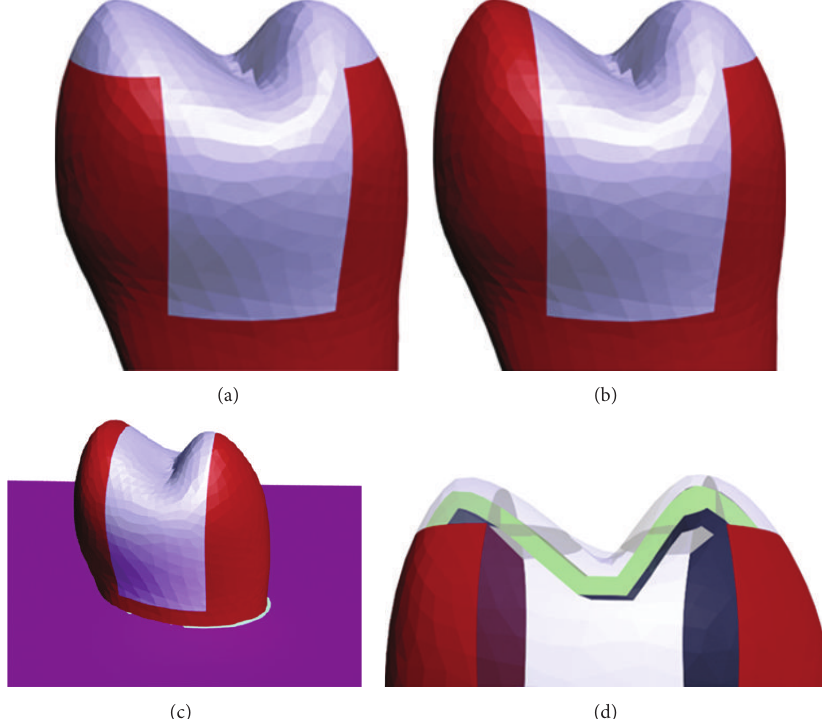
Figure 2: Restorative approaches (a) buccal + palatinal cusps capped, (b) palatinal cusps capped, (c) MOD restoration, and (d) woven fiber used.